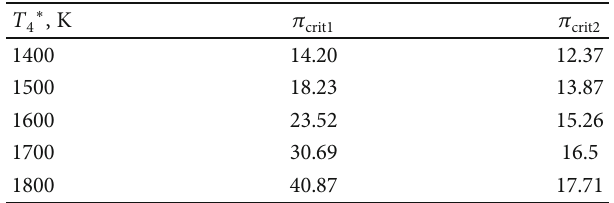
Table 2: Variations in critical compressor pressure ratios π ∗ T π crit2 with 4